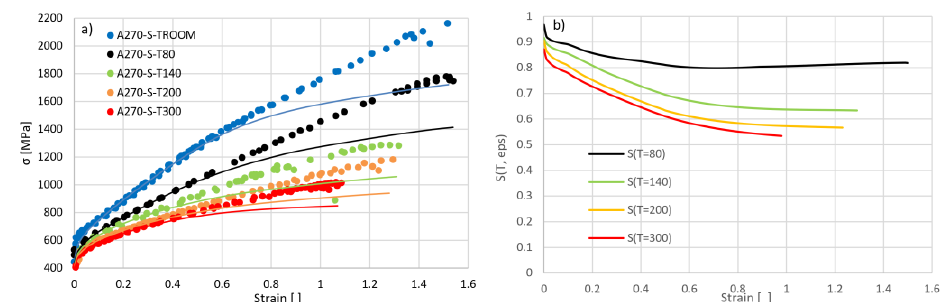
Fig. 1 . Static tests: (a) True stress-strain experimental data at 20, 80, 140, 200 and 300 °C (scatter plots) and corresponding Mises curves (lines); (b) Static thermal softening functions 𝑆 𝑆𝑇